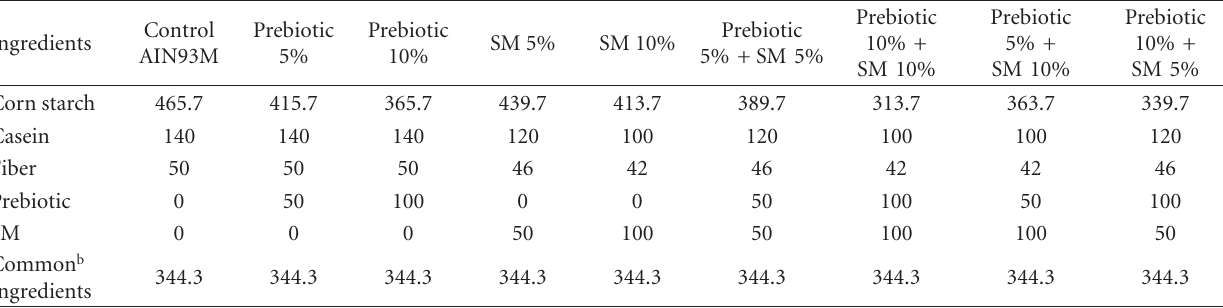
Table 1: Composition of diets a (AIN93-M).